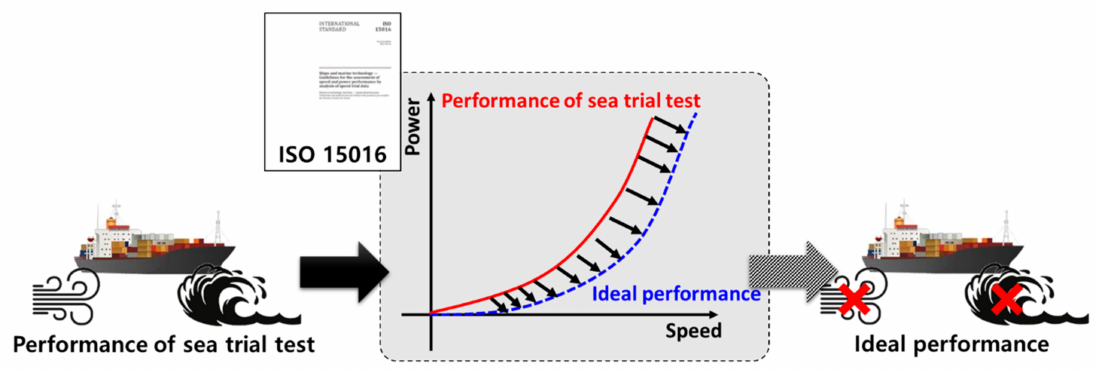
Figure 1. Purpose of ISO